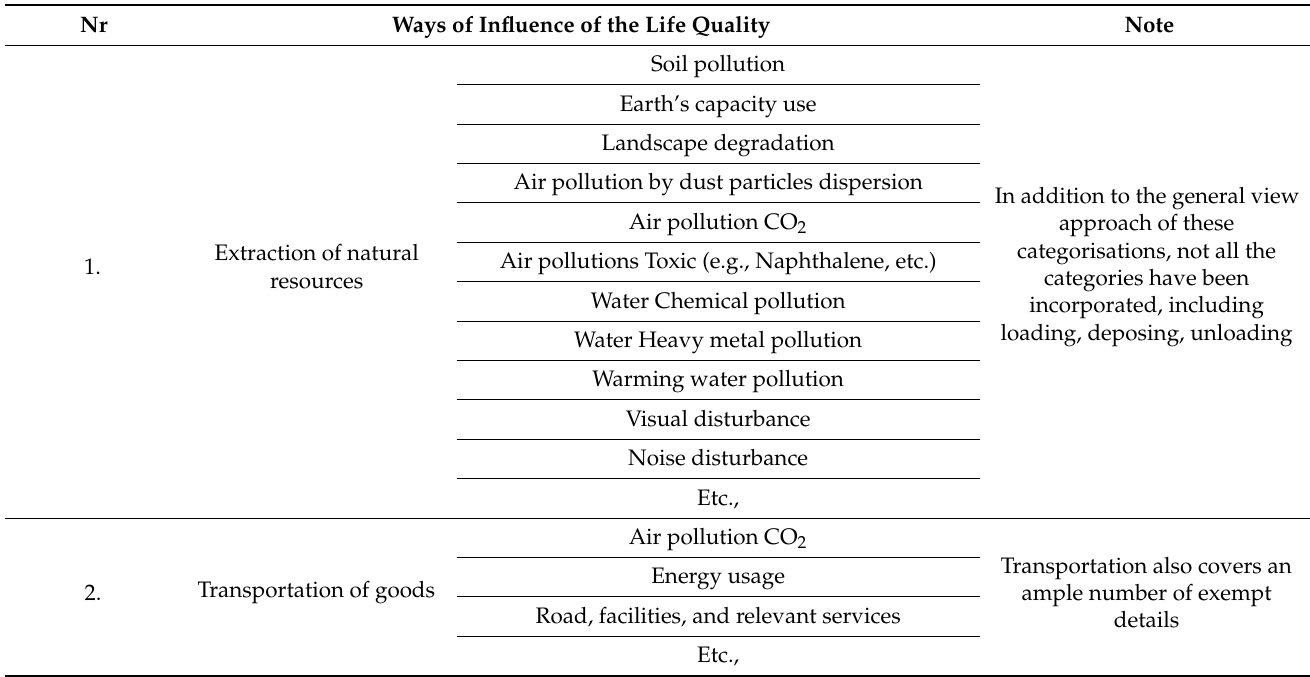
Table 2. Summarised inventory of impacts on health when providing construction materials (CMs) from natural